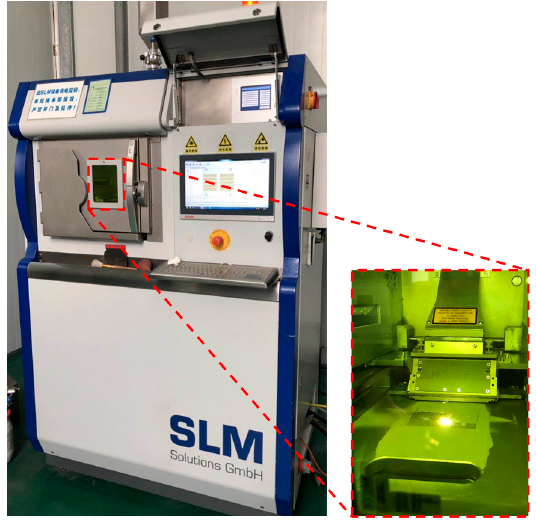
Figure 1. Photograph of the additive manufacturing (AM) equipment (SLM 125). Zoom out viewport: the manufacturing process of the investigated sample.